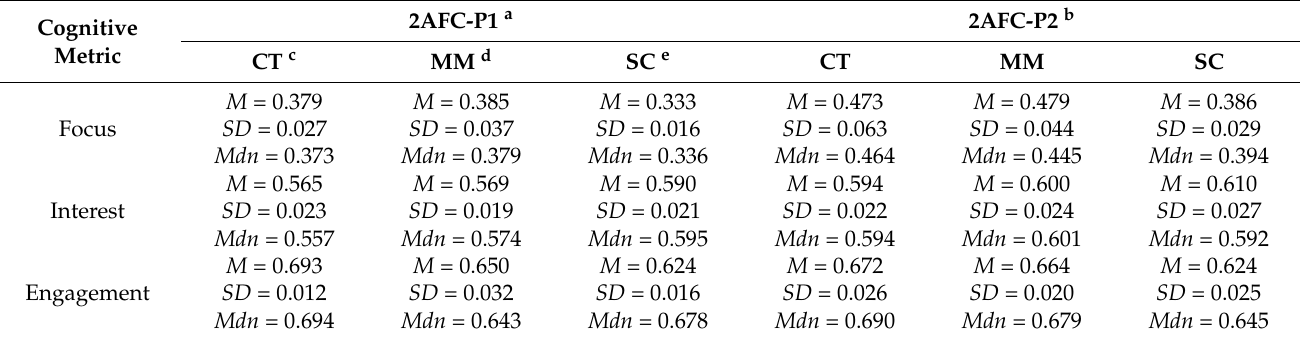
Table 4. Statistical results of performance metrics for 2AFC tests.